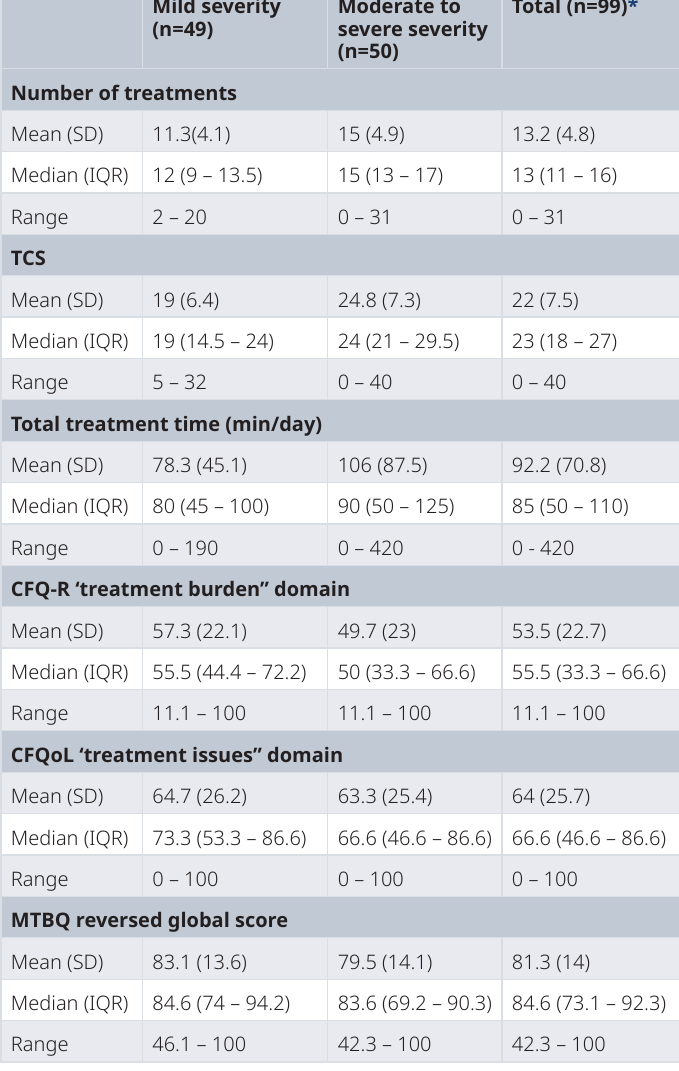
Abbreviations : TCS = treatment complexity